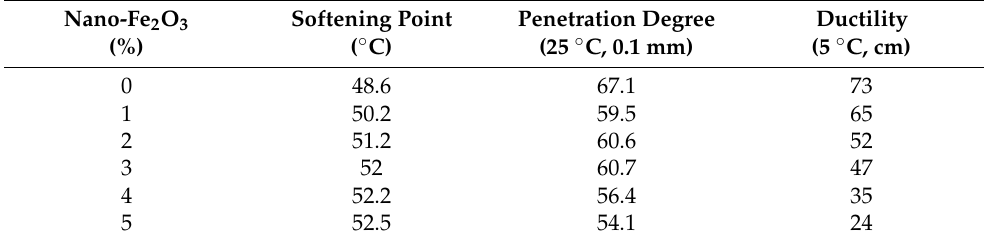
Table 1. Effect of different content of Nano-Fe 2 O 3 on the properties of asphalt composites. Nano-Fe 2 O 3 Softening (%)